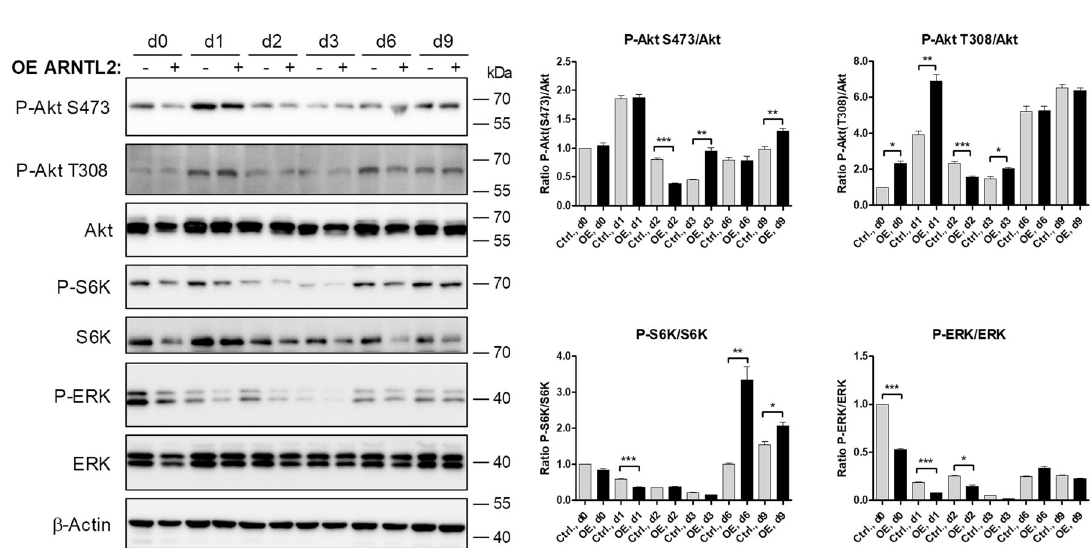
Fig. 7 PI3K/Akt/mTOR and MAPK signaling during adipogenesis in ARNTL2 OE ASCs. Corresponding result to Fig. 6A. See legend of Fig. 6 for